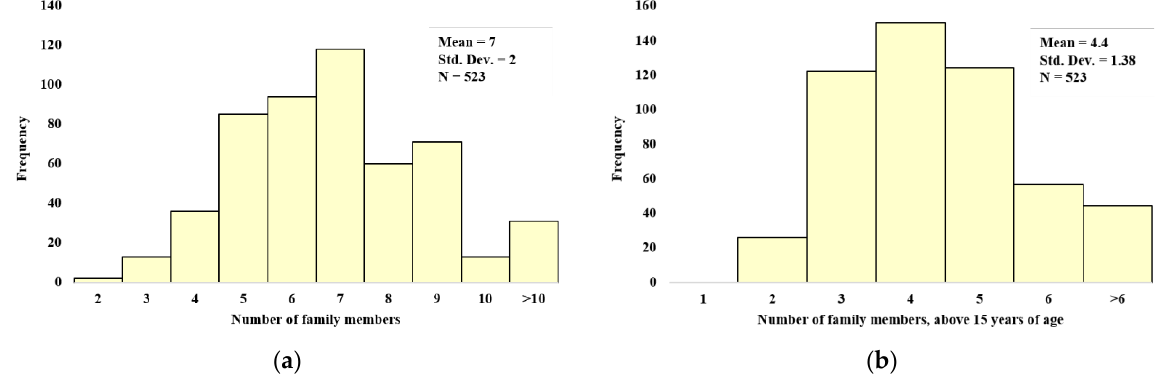
Figure 6. Histograms of ( a ) Family size and ( b ) Number of family members above 15 years of age.